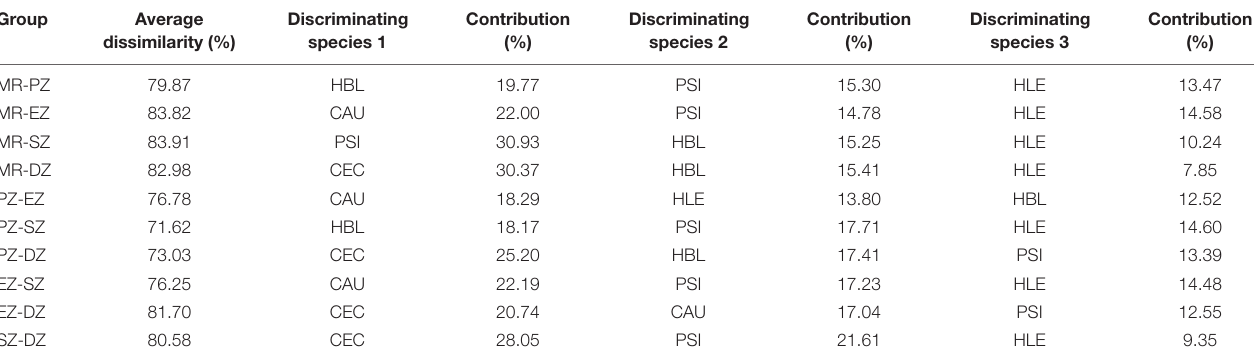
TABLE 5 | Average dissimilarity and corresponding differentiating species of fish among the Mangshe River (MR) and different purification zones of Lake Yanlong (PZ, the pretreatment zone; EZ, the emergent macrophyte zone; SZ, the submerged macrophyte zone; DZ, the deep purification zone). Group Average dissimilarity (%)